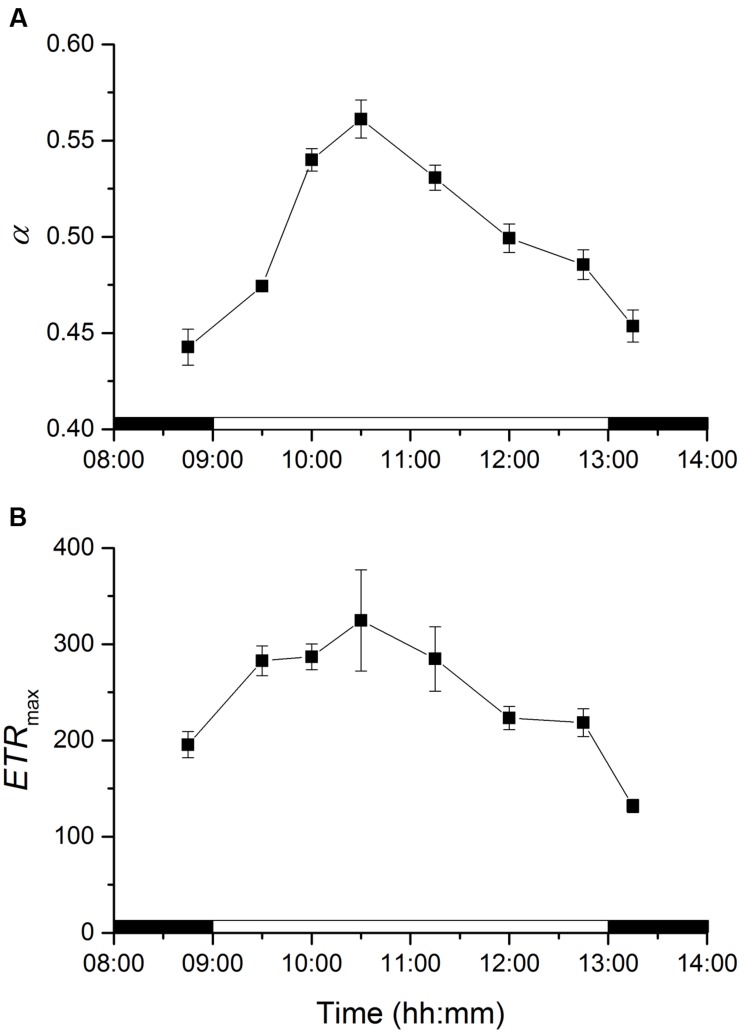
Changes in rapid light curve parameters α (light utilization coefficient, A) and ETRmax (relative maximum electron transport rate, B) of an intertidal sediment over a diel emersion period (mean ± standard deviation; n = 3). The illumination period was between 9 AM and 1 PM at a constant photon irradiance of 150 μmol photons m-2 s-1.